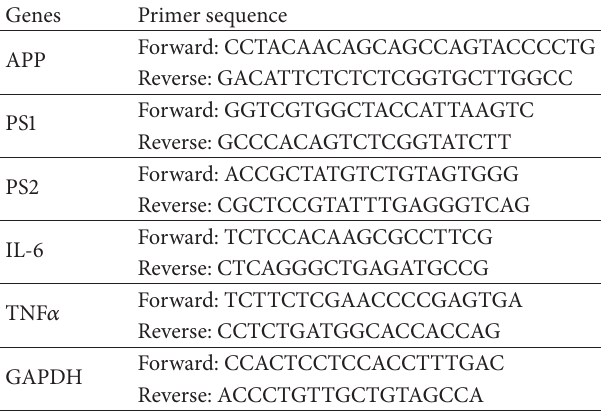
Table 1: Primer sequences of the internal control gene and the target genes for